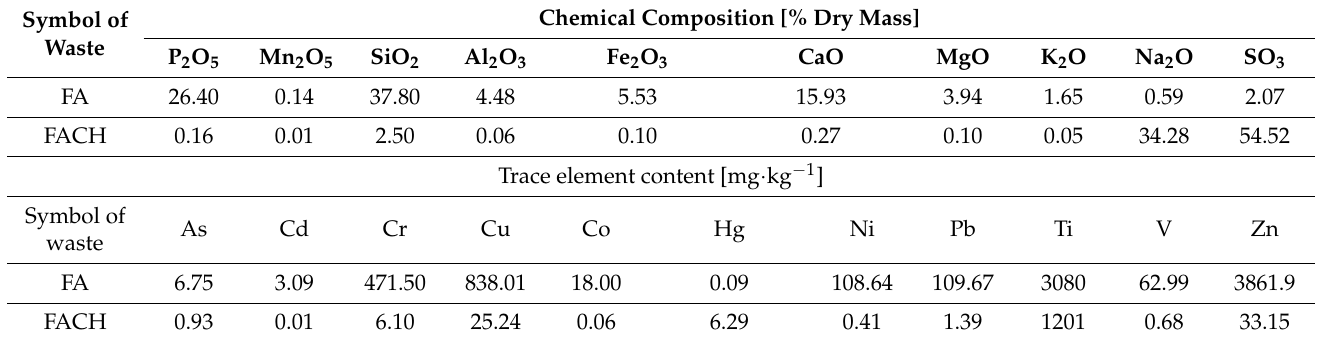
Table 1. Chemical composition of the studies ashes.